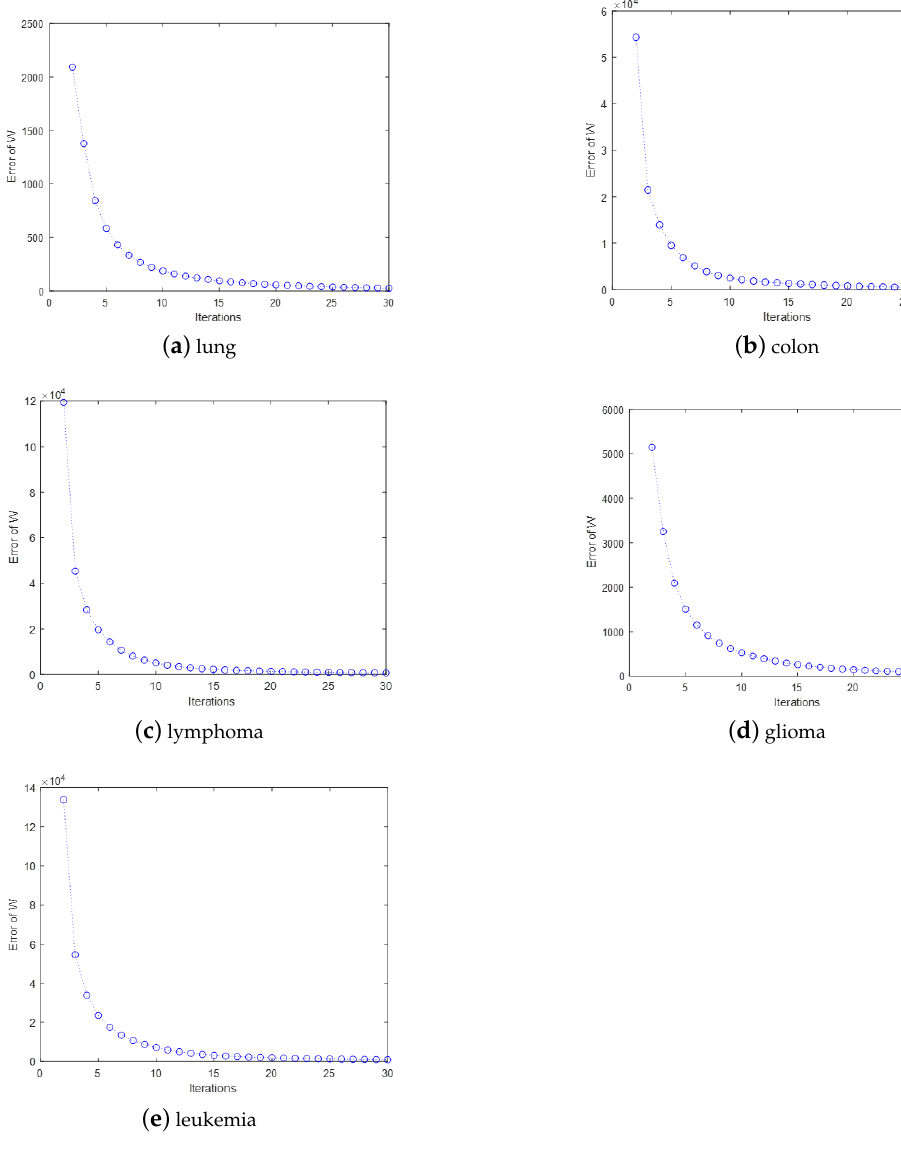
Figure 5. The convergence of W on five gene datasets. Table 4. Comparison of the main computational